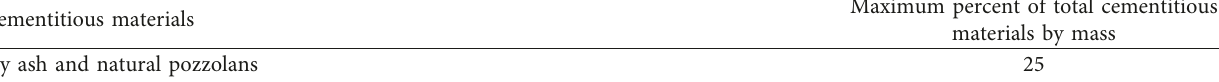
Table 2: Cementitious materials requirements for concrete exposed to deicing chemicals “Table 2 is reproduced from Kosmatka et al. [39]